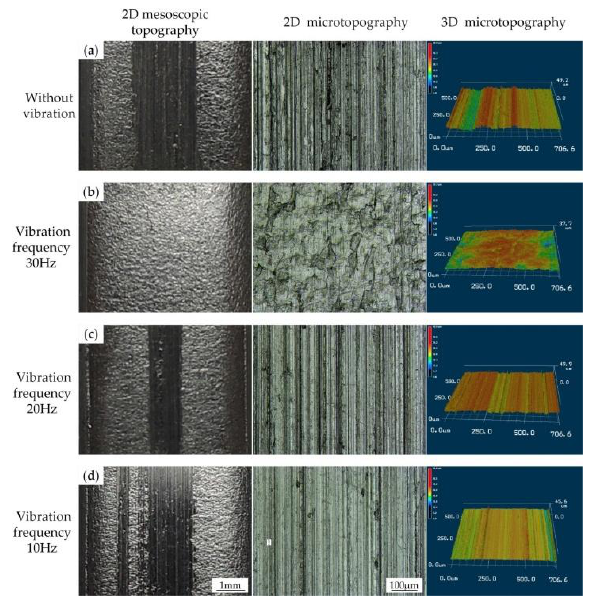
Figure 10. Comparison of the surface quality of clutch hubs formed under different vibration frequencies: ( a ) Without vibration; ( b ) With vibration at frequency 30 Hz; ( c ) With vibration at frequency 20 Hz; ( d ) With vibration at frequency 10